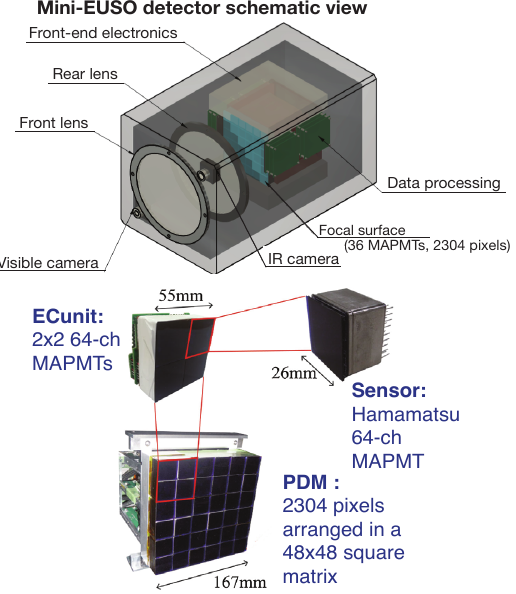
Figure 1: Schematic view of Mini-EUSO telescope (top) and the PDM (bottom).